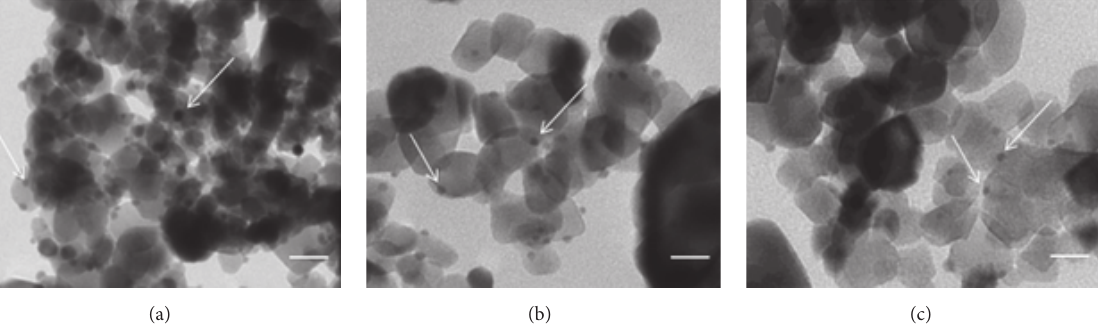
Figure 1: TEM images of silver nanoparticles (arrows) deposited on TiO 2 , synthesized at pH 9 (a), pH 11 (b), and pH 12 (c). At all the pH values showed, nanoparticles presented the same form with an average size ranging from 5.6 to 6.0 nm, while the average size of TiO 2 was 35 ± 10 nm. At pH 9, Ag nanoparticles were more abundant. The scale line represents 20